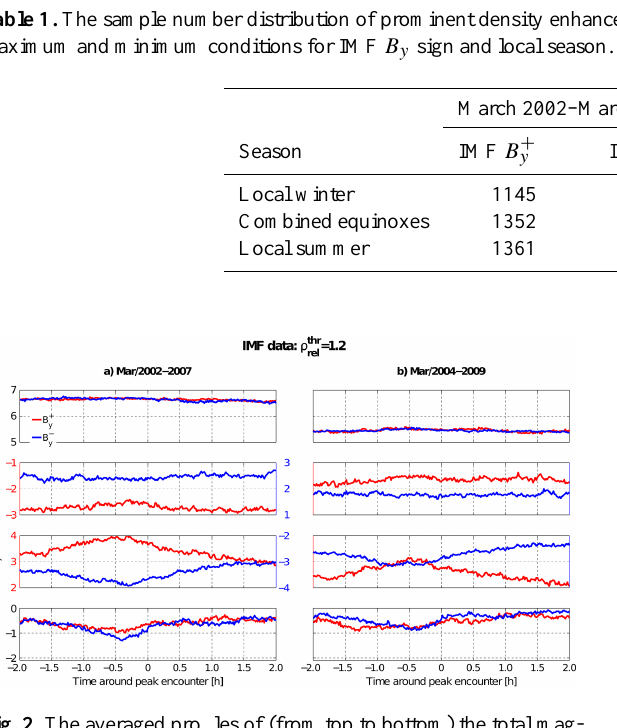
= 1 . 2. The results are listed separately for solar , for ρ thr rel rel